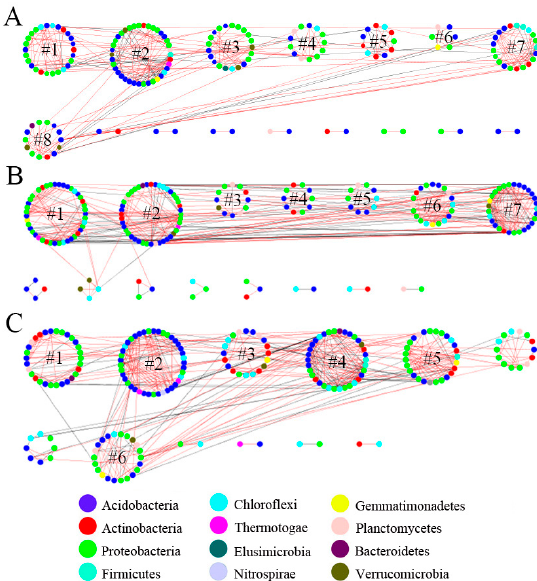
Figure 1. The molecular ecological network of soil bacteria in the topsoil (0–20 cm) ( A ), middle layer (20–40 cm) ( B ), and subsoil (40–60 cm) ( C ) of native tree plantations. Each node represents an OTU of bacteria, and the color of the node represents the phylum level of bacteria. The red line indicates the positive interaction between nodes, and the gray line indicates the negative interaction between nodes. # k , Module k , k = 1, 2, 3, …… .